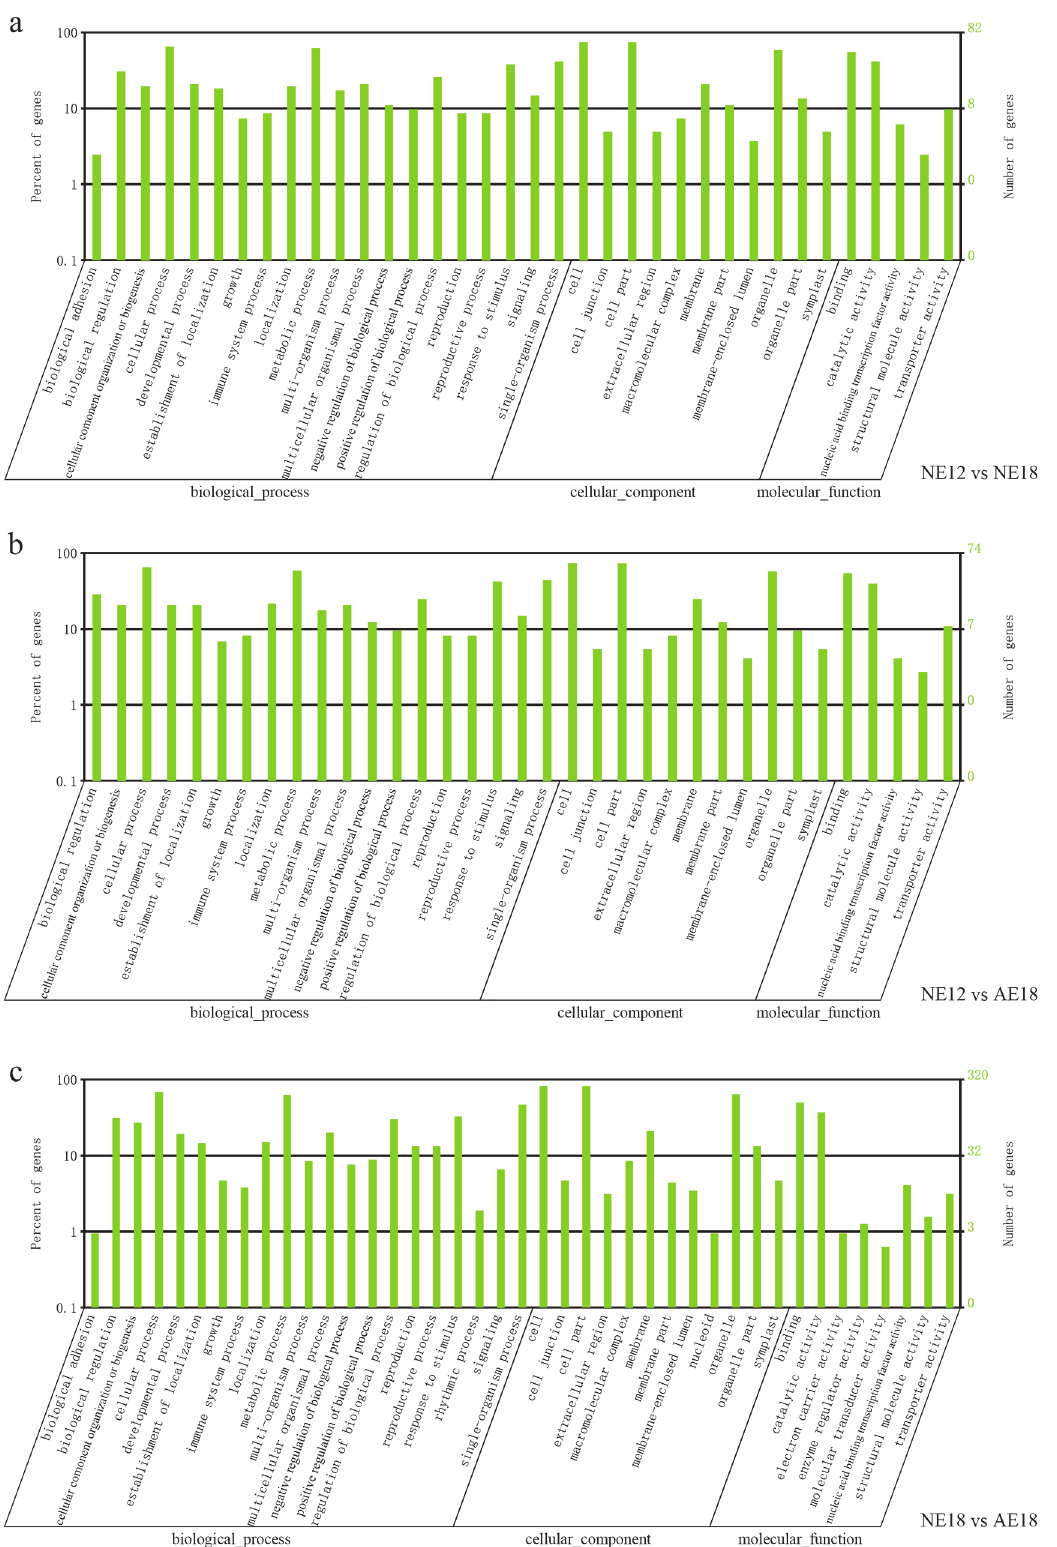
Fig 3. Gene Ontology (GO) classifications of putative targets in the chrysanthemum embryo.